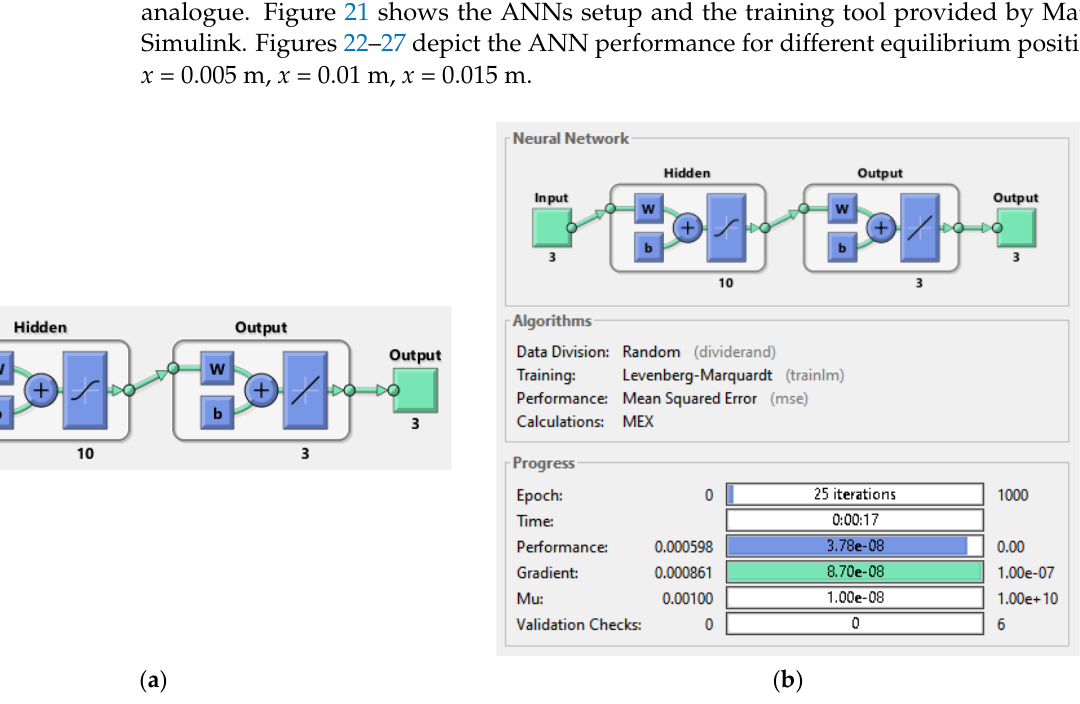
Figure 21. ( a ): ANN architecture setup; ( b ): Matlab Simulink ANN training tool.